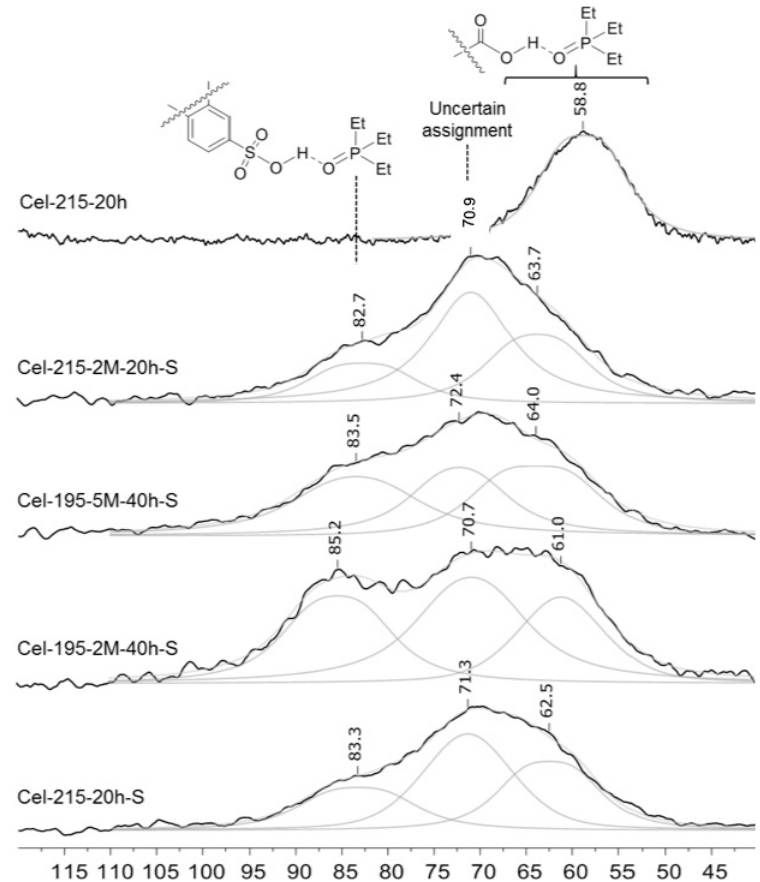
Figure 6. 31 P- MAS-RMN spectra of TEPO adsorbed on one HTC sample (Cel-215-20 h, sample 4) and SHTC (samples 6-S, 8-S, 7-S, and 4-S from the top to the bottom) .